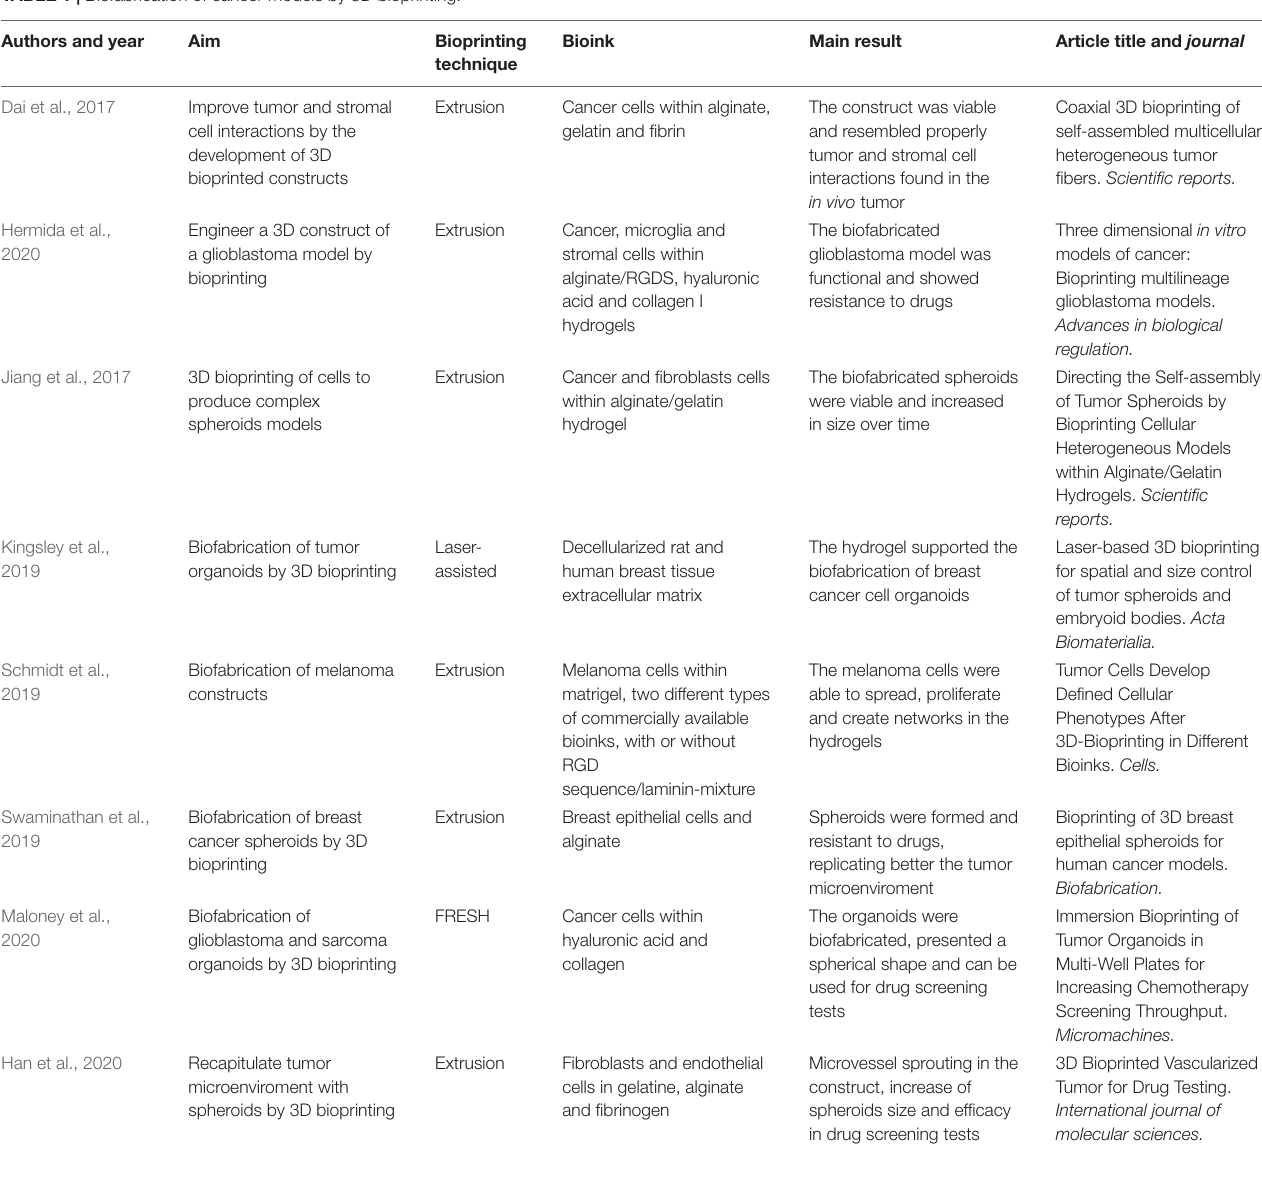
TABLE 1 | Biofabrication of cancer models by 3D